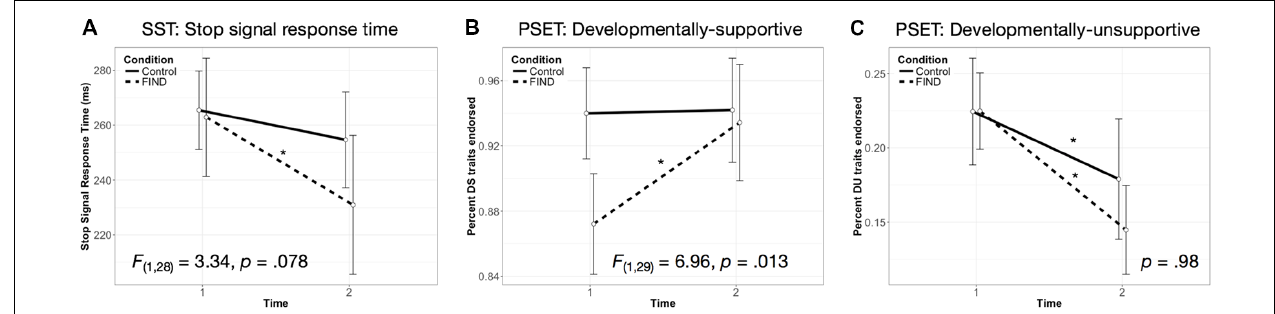
FIGURE 1 | Group by time effects on behavior during the stop signal task (SST) and parenting self-evaluation task (PSET). The Filming Interactions to Nurture Development (FIND) group showed (A) a significant decrease in stop-signal response time (SSRT), F ( 1,28 ) = 8.53, p = 0.007, not seen in the CTL group, p = 0.8, (B) a significant increase in endorsement of DS traits, F ( 1,29 ) = 12.45, p = 0.001, not seen in the CTL group, p = 0.82, and (C) a significant decrease in endorsement of DU traits over time, F ( 1,29 ) = 4.87, p = 0.035, which the CTL group also showed, F ( 1,29 ) = 5.07, p = 0.032. Note: ∗ p < 0.05. Error bars indicate 95% confidence interval.